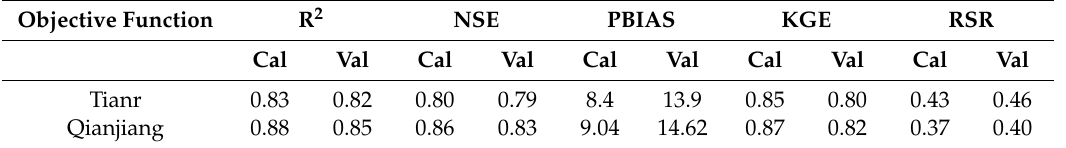
Table 10. Performance indices for Tianr and Qianjiang Hydrological